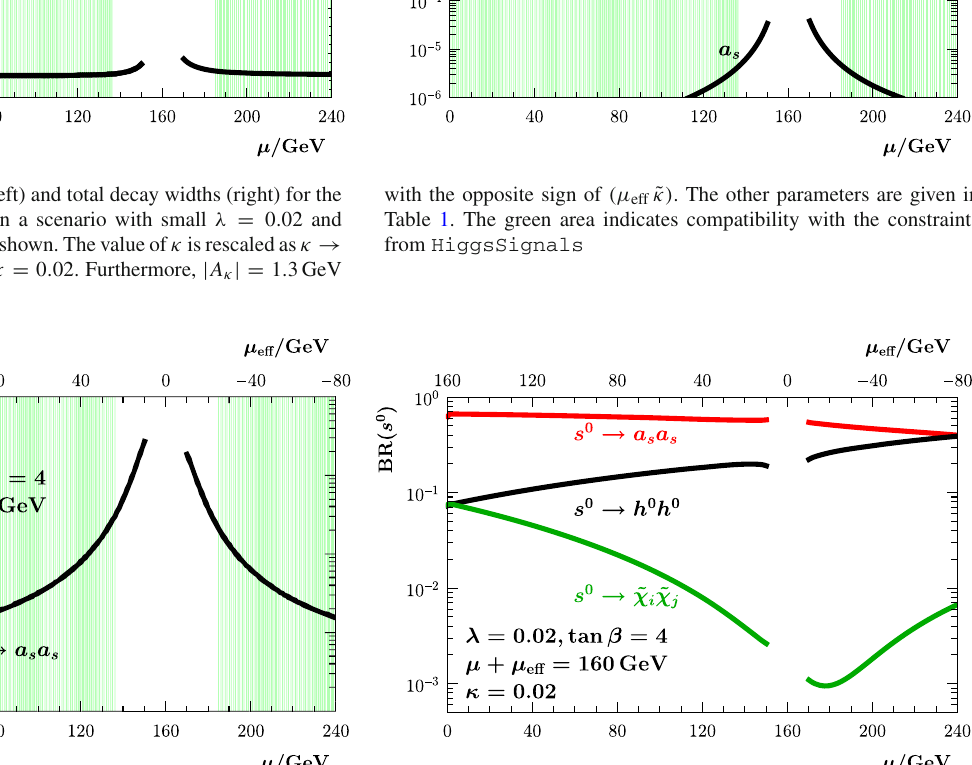
patibility with the constraints from HiggsSignals . The branching ratio BR ( s 0 → ˜ χ i ˜ χ j ) includes all branching ratios of s 0 into pairs of neutralinos and